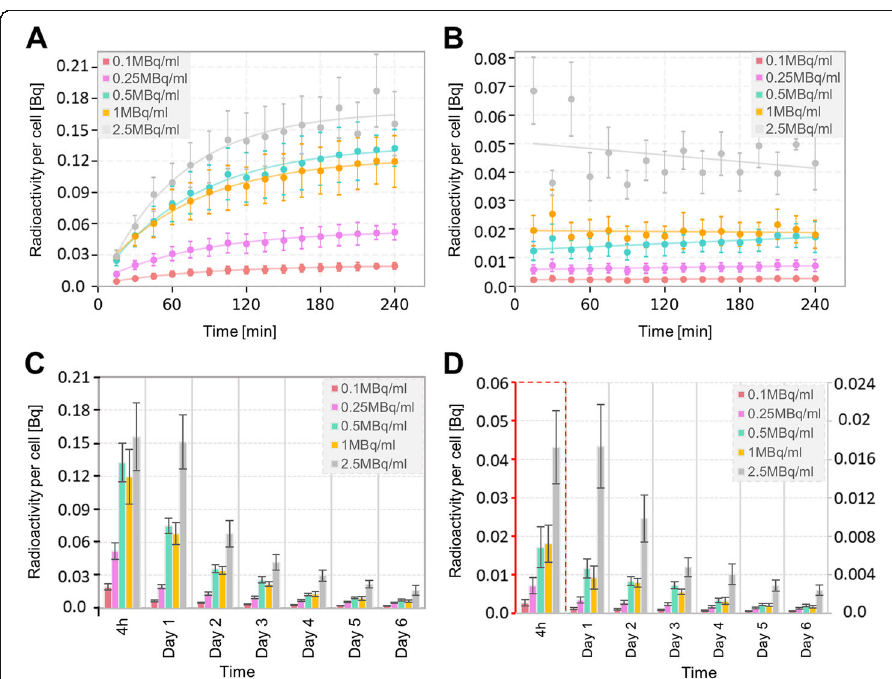
Fig. 7 Activity quantification. Internalized a and b membrane bound activity curves per cell during the 4 h uptake. Internalized c and d membrane bound activity per cell at the end of the 4 h uptake and in each following day. The curves corresponding to 0.1 MBq/ml and 0.25 MBq/ml are extrapolated. The error bars indicate the SD of uptake